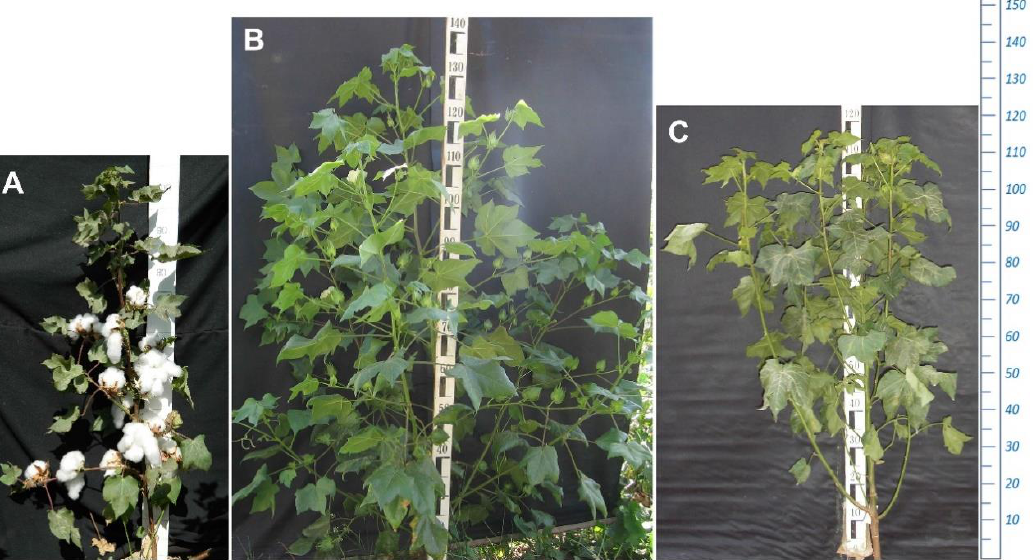
Figure 1. ( A ) ♀ — Day-neutral mutant line (var. Kupaysin); ( B ) F 1 — hybrid of the first generation; ( C ) ♂ — photoperiod-sensitive wild-type G. hirsutum subsp. purpurascens (var. El-Salvador). Table 1. Average values of morphological and agronomical traits of the parents, F 1 hybrid, and F 2 progeny.